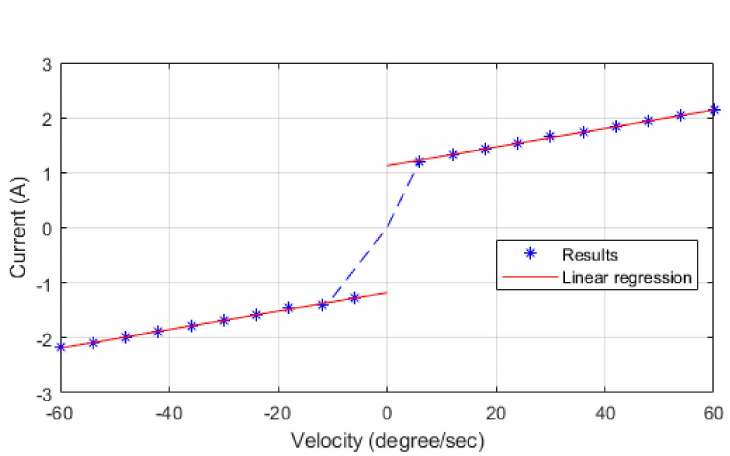
Figure 3. Velocity–current